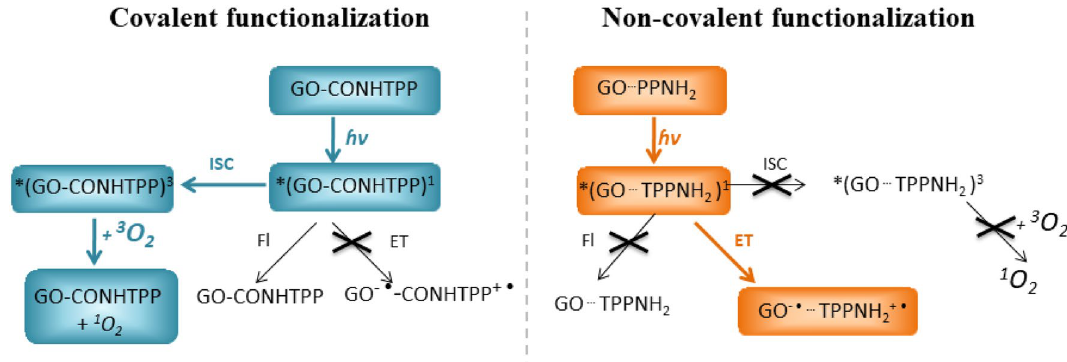
Figure 12. Possible deactivation paths of the excited states of GO-CONHTPP and GO-TPPNH 2 discussed in text ( Fl fluorescence, ET electron transfer). Deactivation paths important for practical application were marked in blue and orange for GO-CONHTPP and GO-TPPNH 2 ,